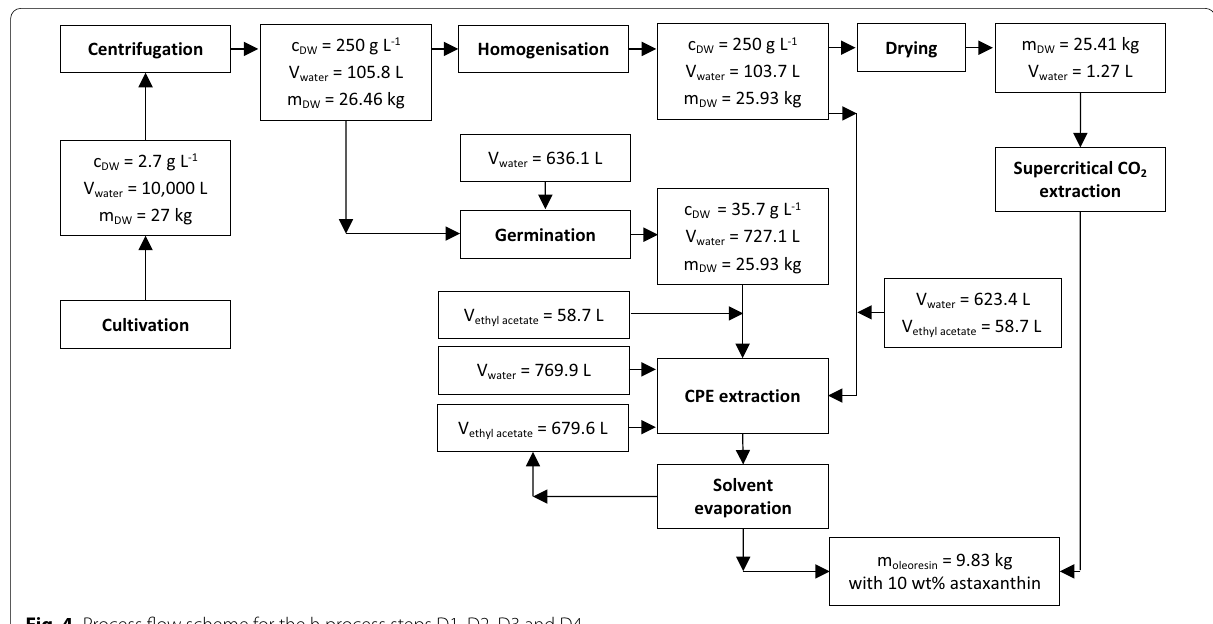
Fig. 4 Process flow scheme for the h process steps D1, D2, D3 and D4